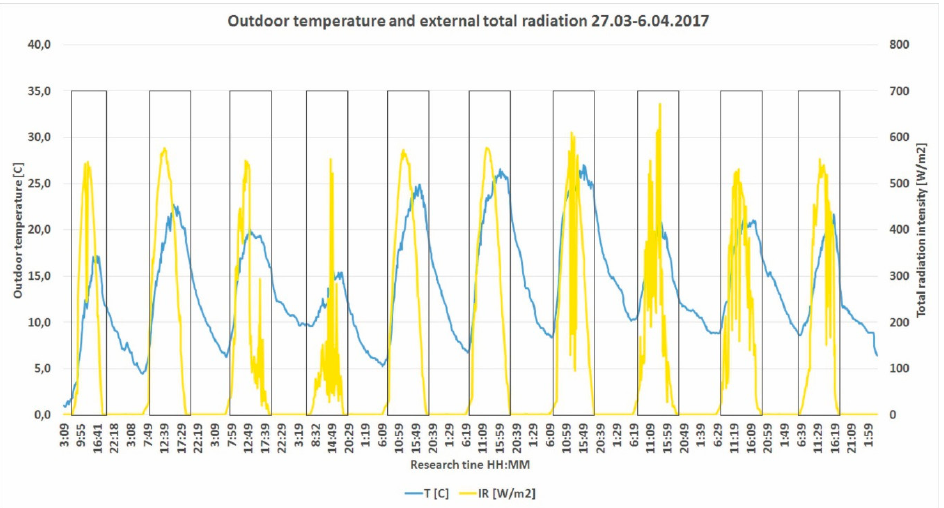
Figure 7. Waveform of outdoor air temperature and total solar radiation between 27 March and 6